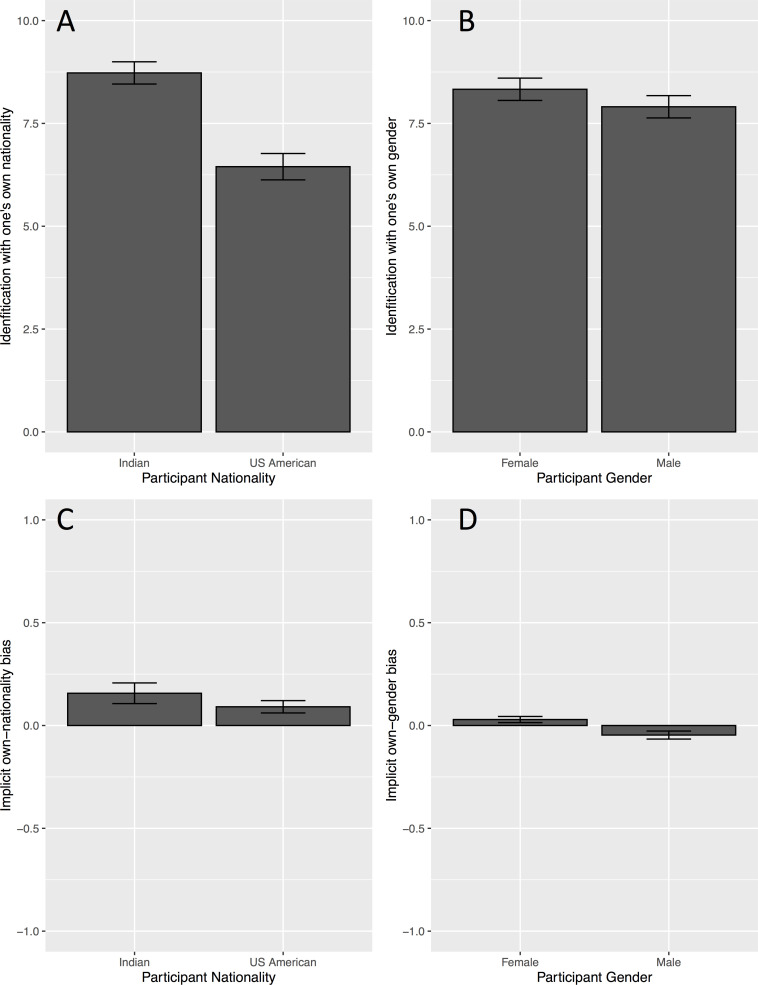
Participants explicitly identified with both their nationality and gender, and implicitly preferred their nationality.Females also have an implicit own-gender bias, while males have a female bias. (a) Nationality identification by participant nationality on the left, (b) gender identification by participant gender on the right. (c) Nationality difference scores in the AMP plotted against participant nationality (left), (d) and gender difference scores in the AMP plotted against participant gender (right). AMP difference scores (c, d) above 0 indicate ingroup bias in our implicit measure, while scores below 0 indicate outgroup bias. All error bars represent 95% confidence intervals.